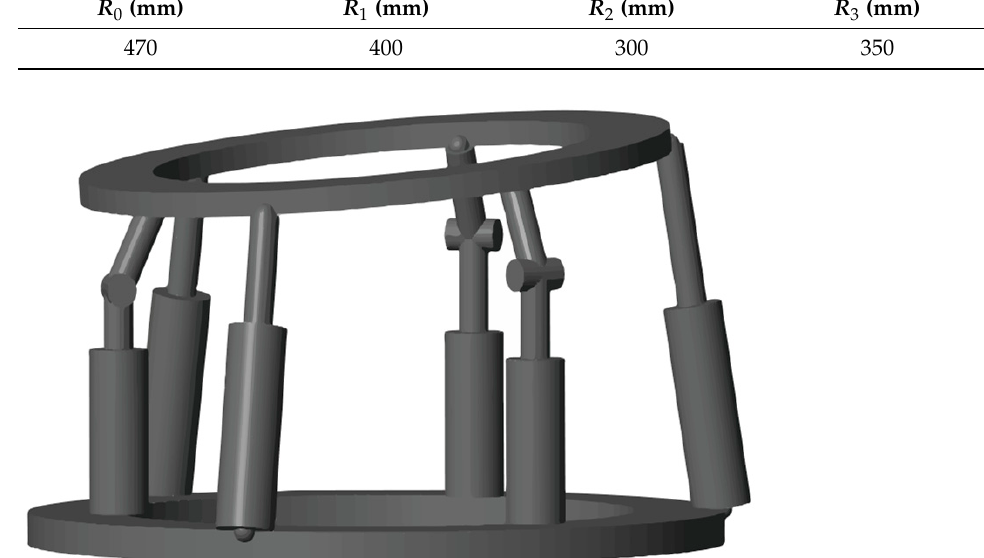
Figure 7. The simulative model for this example PM.